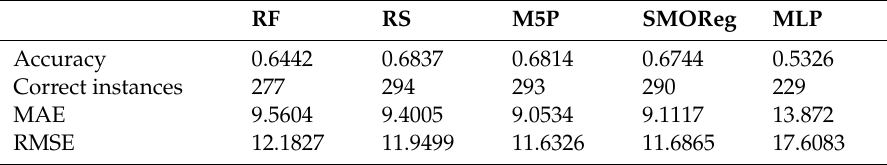
Table 3. Performance of the regression-based models.